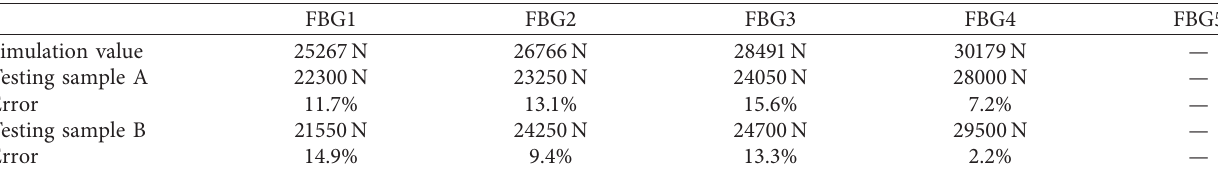
Table 1: Analysis of the experiment results of testing samples A and B.